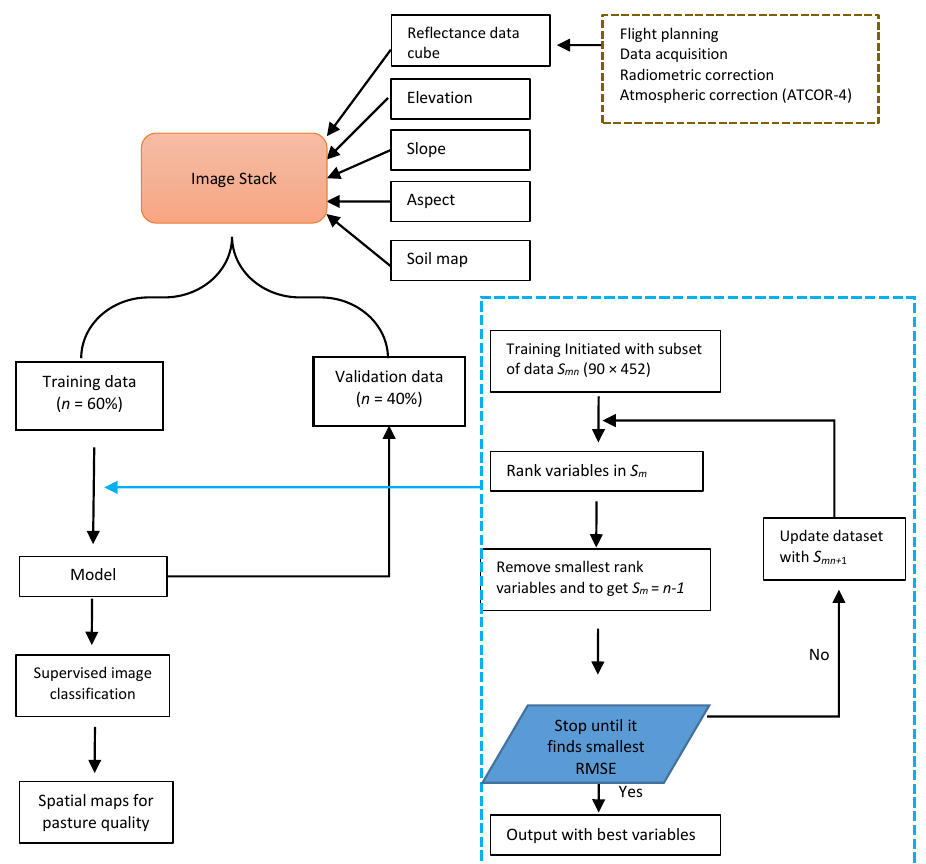
Figure 3. The workflow of the proposed procedure for creating pasture-quality maps.